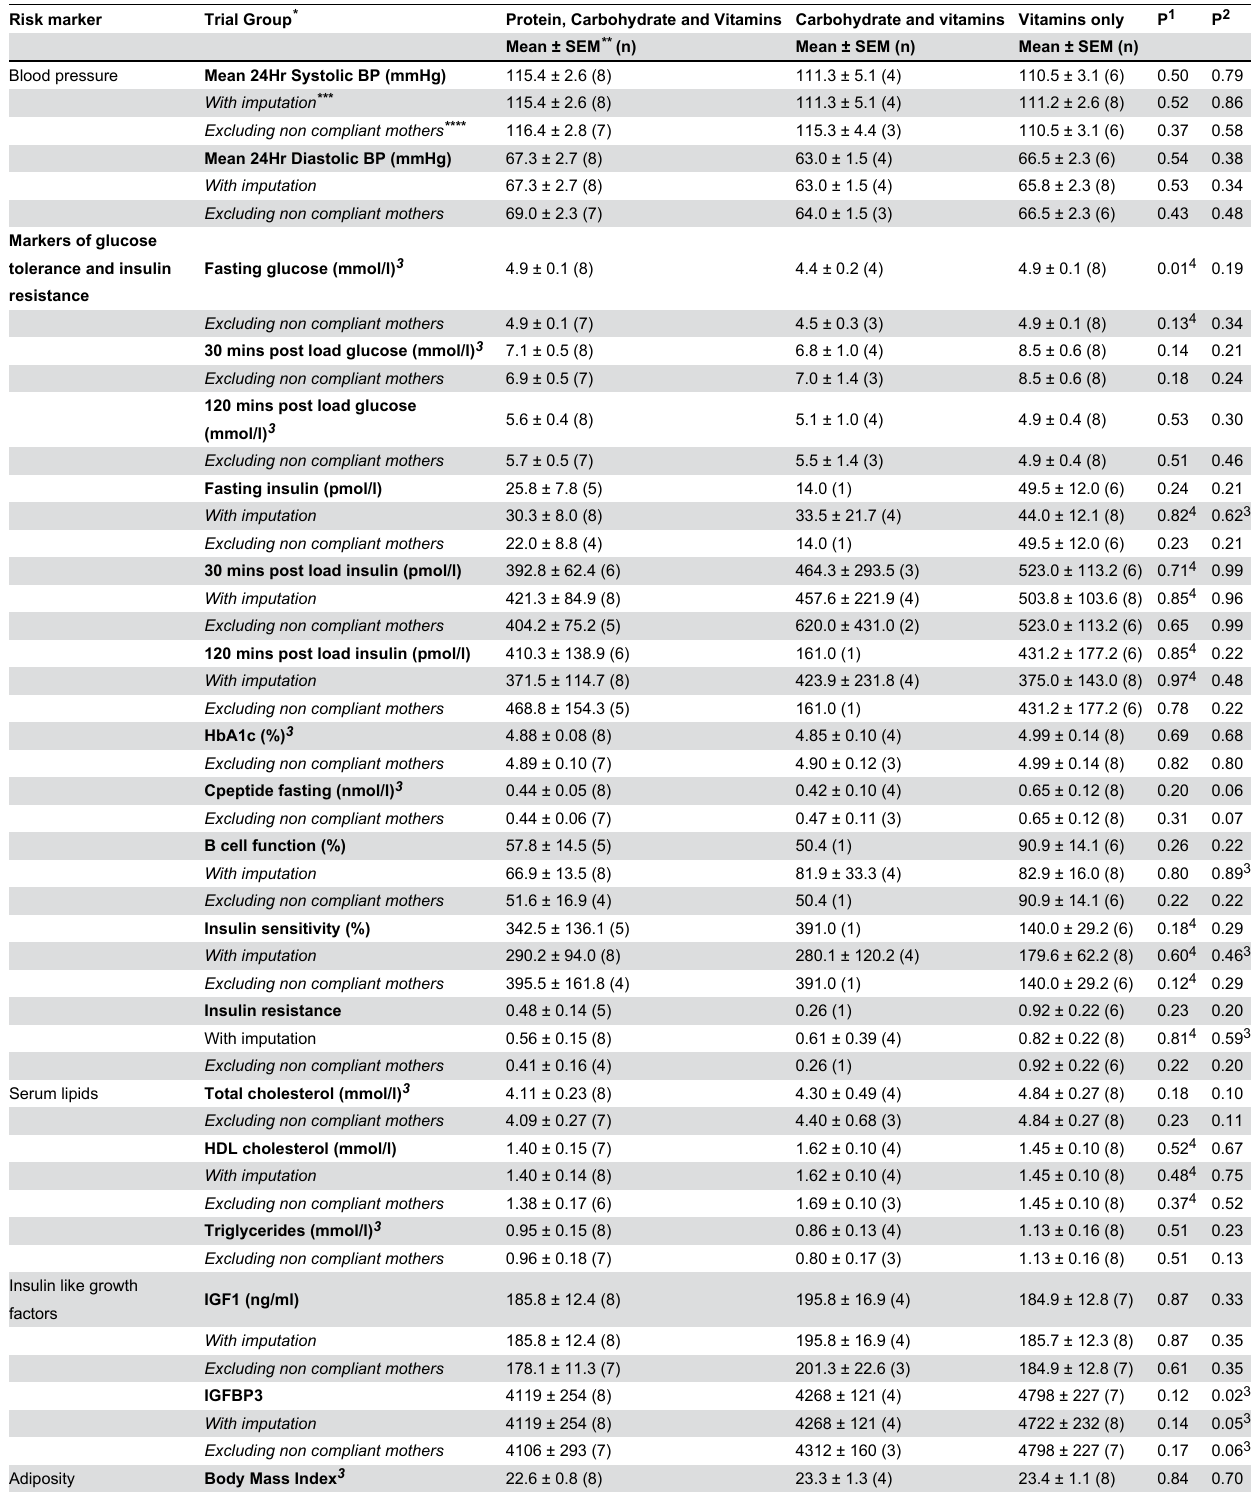
Table 5. Adult disease risk markers amongst offspring of mothers participating in the Sorrento studies of maternal nutritional supplementation who were assessed as adults before and after imputation of missing values - Trial II (supplementation in nutritionally at risk mothers after 28